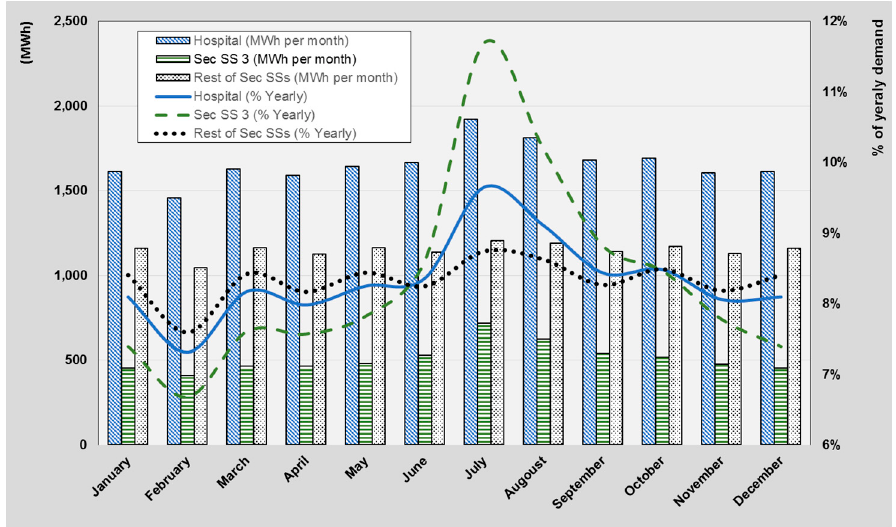
Figure 2. Monthly electricity demand in the hospital and percentage of monthly demand over the annual: Hospital, Sec SS 3 and Rest of Sec SSs (1, 2 and 4).